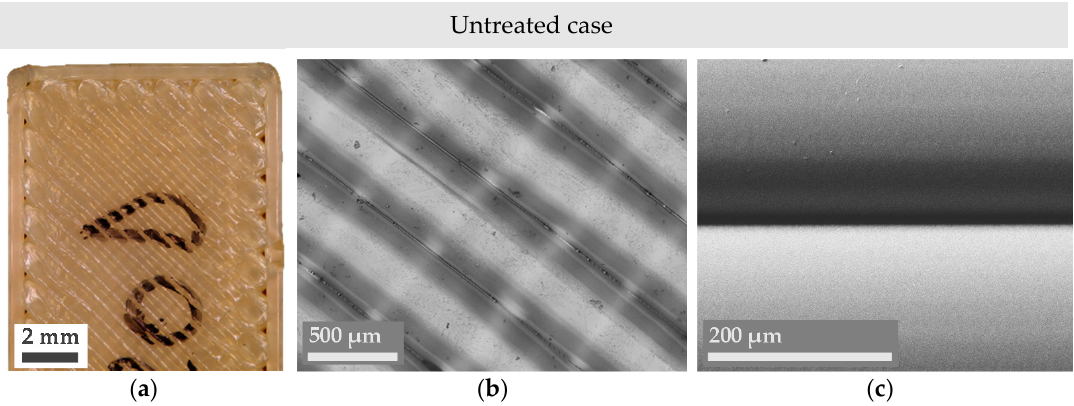
Figure 2. Digital microscope ( a , b ) and SEM micrographs ( c ) of untreated Ultem parts.